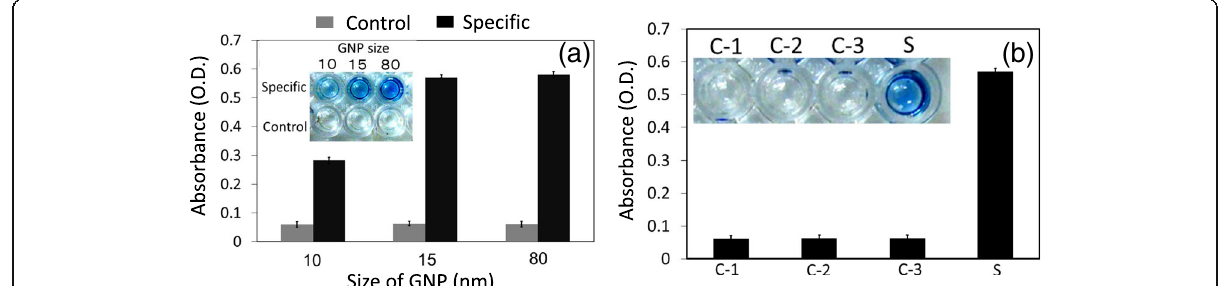
Fig. 4 a Determining the ideal size of GNP. Among 10, 15, and 80 nm, 15 and 80 nm showed similar results. Fifteen nanometers was used to determine the limit of detection with FIX. b A control experiment for the detection of FIX. Three different control experiments (C1 — without FIX antibody; C2 — without anti-mouse IgG; C3 — without FIX) were conducted. No significant signal was found in any of the control experiments. Figure insets display the visual